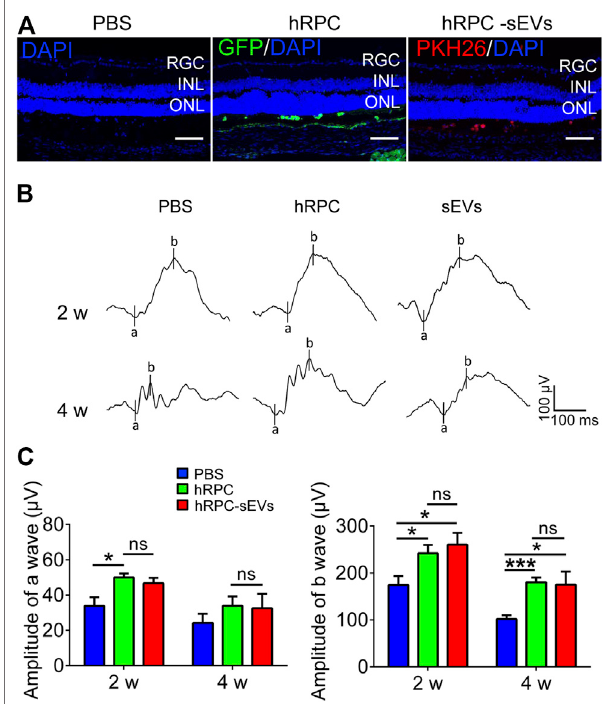
FIGURE 1 | Effects of hRPCs and hRPC-sEV treatment on visual function in RCS rats. (A) Confocal images showing RCS retina injected with PBS (L), GFP-labeled (green) hRPC (M), or PKH26-labeled (red) hRPC-sEVs (R) in subretinal space. Scale bars, 50 μ m. (B) Representative scotopic fERG waveforms elicited at 1 log(cd*s/m 2 ) light intensity in PBS (untreated groups),hRPCs,andhRPC-Exosgroupsat2and4weeksafterinjection(n (cid:2) 5 eyes). (C) Statisticalanalysisofscotopic fERG a-waveamplitudes (leftpanel) andb-waveamplitudes (rightpanel) elicitedat1log(cd*s/m 2 )lightintensityin PBS (untreated groups), hRPCs, and hRPC-sEVs groups at 2 and 4 weeks after injection (n (cid:2) 5). Data are shown as means ± SEM. * p < 0.05, ** p < 0.01, and *** p <